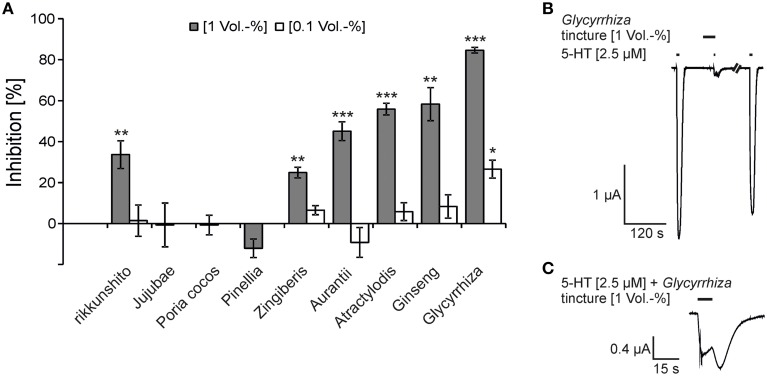
Inhibition of 5-HT3A receptors by tinctures of rikkunshito and its constituents (A) and original traces from the inhibition by the
Glycyrrhiza
tincture (B,C). (A) The dark bars represent the inhibition at 1 Vol.-%, and the bright bars represent that at a concentration of 0.1 Vol.-%. The inhibition from left to right are as follows: 33.7 ± 6.8%, 1.5 ± 7.6%, −0.7 ± 10.7%, −0.7 ± 4.8%, −12.0 ± 4.5%, 24.9 ± 2.6%, 6.5 ± 2.2%, 45.1 ± 4.6%, −9.2 ± 7.3%, 55.9 ± 2.8%, 5.8 ± 4.3%, 58.3 ± 8.1%; 8.4 ± 5.7%, 84.6 ± 1.4% and 26.6 ± 4.4% (n = 5 − 8) (*p < 0.05; **p < 0.005; ***p < 0.0005). (B,C) The time of application is denoted by the application bars above the trace. The inhibition was reversible after a 150-s washout (holding potential = −60 mV). (C) The 5-HT-induced currents showed a characteristic rebound when co-applied with the Glycyrrhiza tincture.